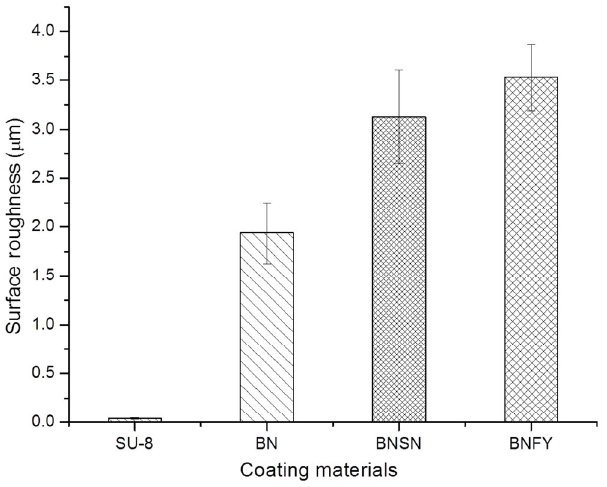
Fig. 5 Surface roughness of the different coating materials.